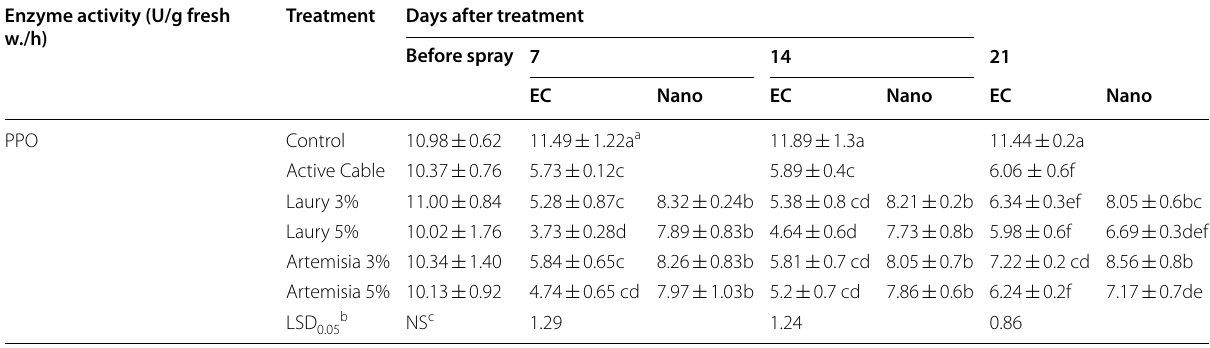
Each value represents the mean of three replicates a Means with different letters within each interval were significantly different at the 0.05 level (Duncan’s multiple range test) b Least significant difference at 0.05 level of probability c Non‑significant difference at 0.05